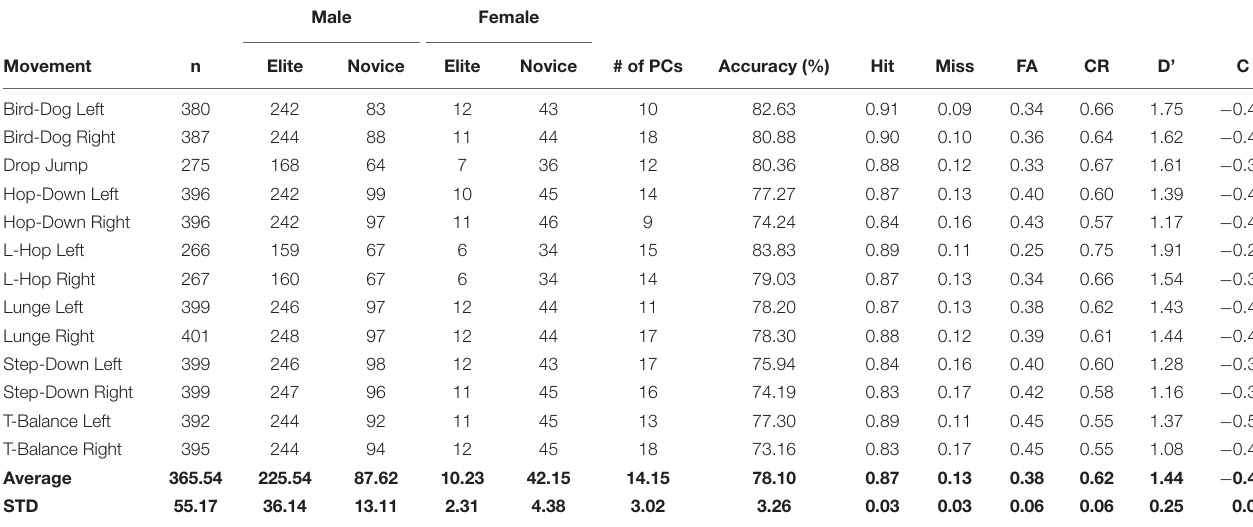
Bold values represent the average and standard deviation across all movement